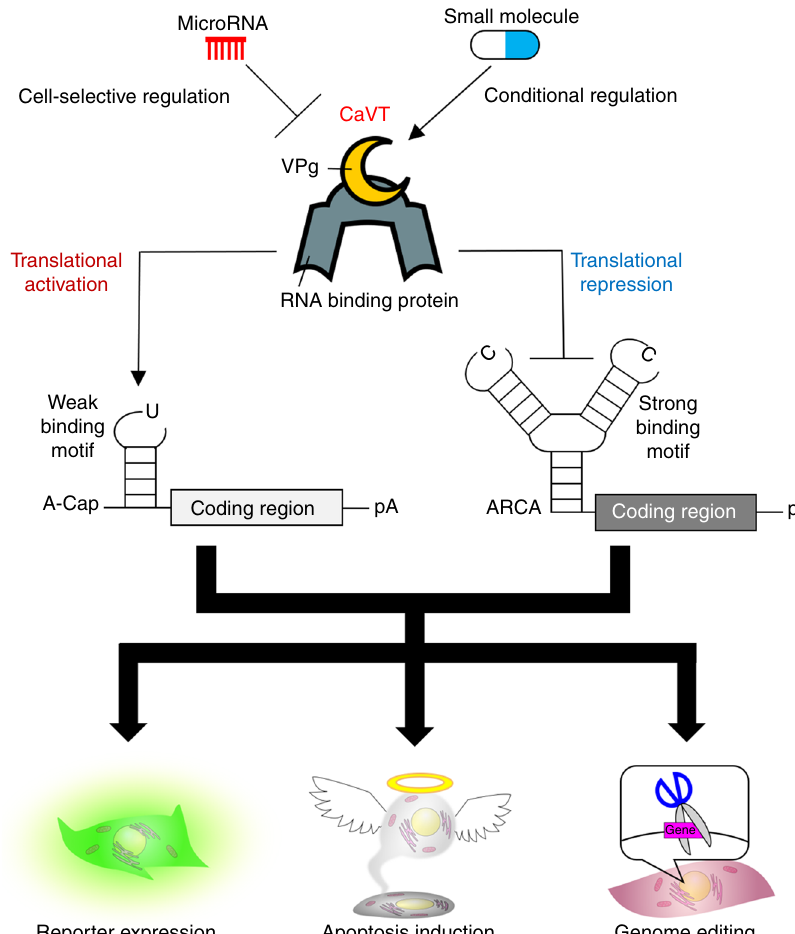
Fig. 1 Graphical abstract of translational regulation by CaVT. CaVT can act as both a translational activator and repressor. While mRNAs containing a weak binding motif are translationally activated by CaVT, mRNAs containing a strong binding motif are translationally repressed by CaVT. Through these translational regulations, CaVT can be used to control reporter expression, apoptosis induction, and genome editing. The implementation of microRNA- or small molecule responsiveness to CaVT enables cell selective or conditional regulation of these biological